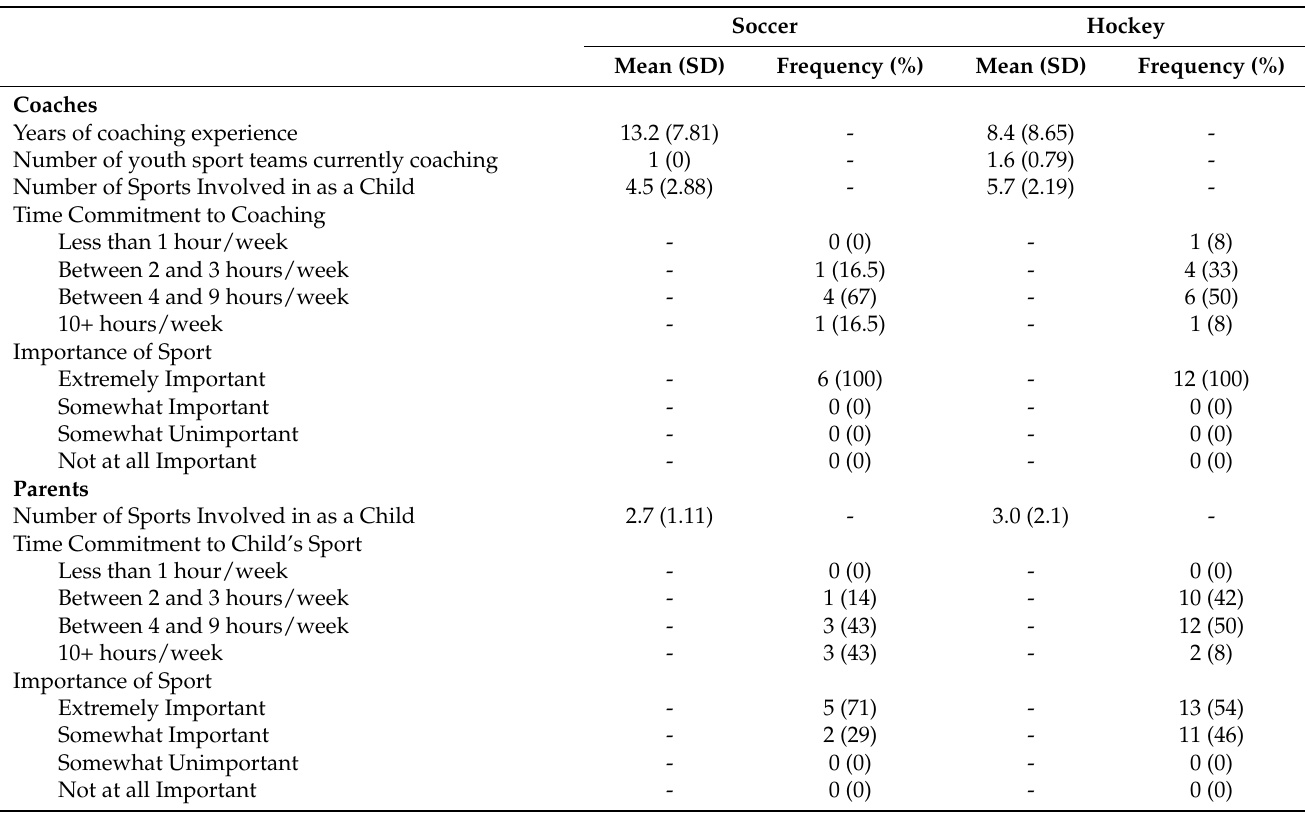
Table 2. Participant Sport and Demographic